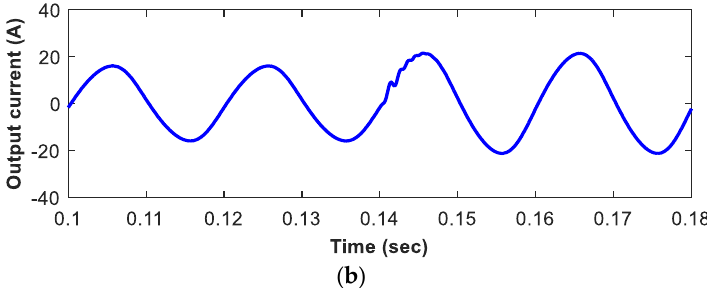
Figure 8. Input voltage changes suddenly (from 90 V to 120 V) and load at 10 Ω for CUK-based ZSI. ( a ) Load voltage; ( b ) load current.